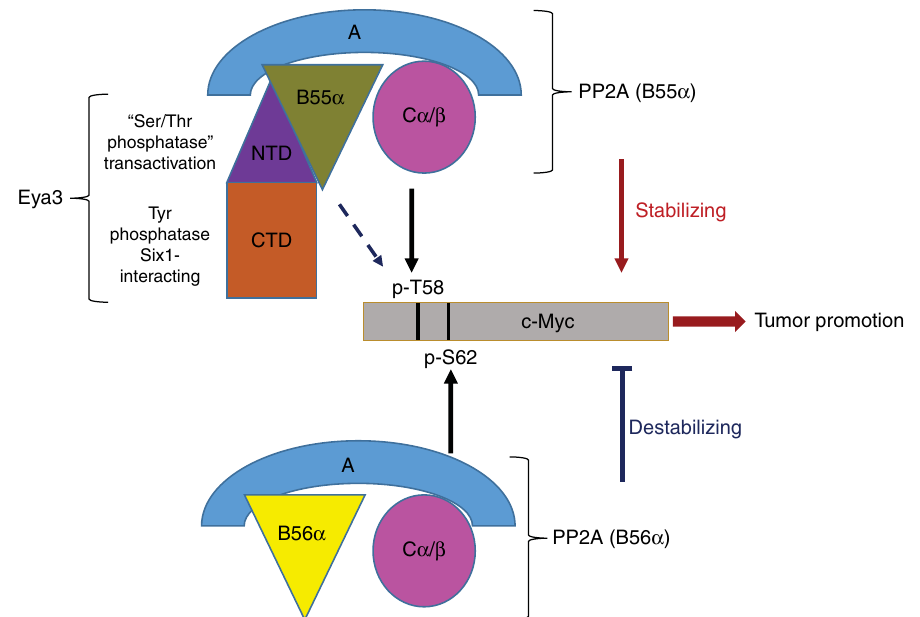
Fig. 8 Schematic representation of the multiple functions of Eya. The N-terminal domain (NTD) of Eya3 possesses transactivating potential and “ Thr phosphatase activity ” , while the C-terminal domain is essential for interacting with Six family members and contains Tyr phosphatase activity. In this paper, we reveal that the apparent Eya3 Thr phosphatase activity arises from an association between the Eya3 NTD and the B55 α subunit of PP2A. Previous studies demonstrate that PP2A – B56 α dephosphorylates pS62 and causes c-Myc degradation, resulting in tumor suppression. In contrast, we demonstrate that when Eya3 is present, the Eya3 – PP2A – B55 α complex dephosphorylates pT58 and stabilizes c-Myc (it is possible that Eya3 directly interacts with c- Myc and brings PP2A-B55 α to c-Myc), leading to tumor promotion. Taken together, Eya3 serves as a key regulator of PP2A to modulate